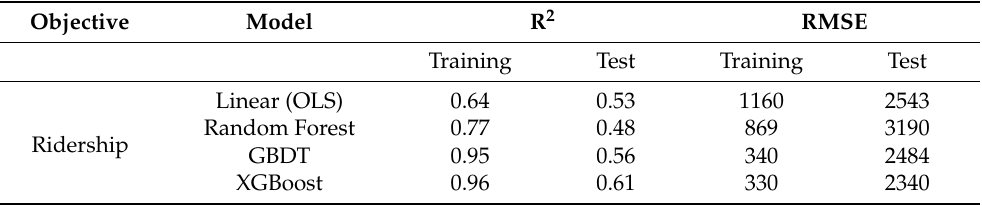
Table 2. Model performance of XGBoost, linear model, and tree